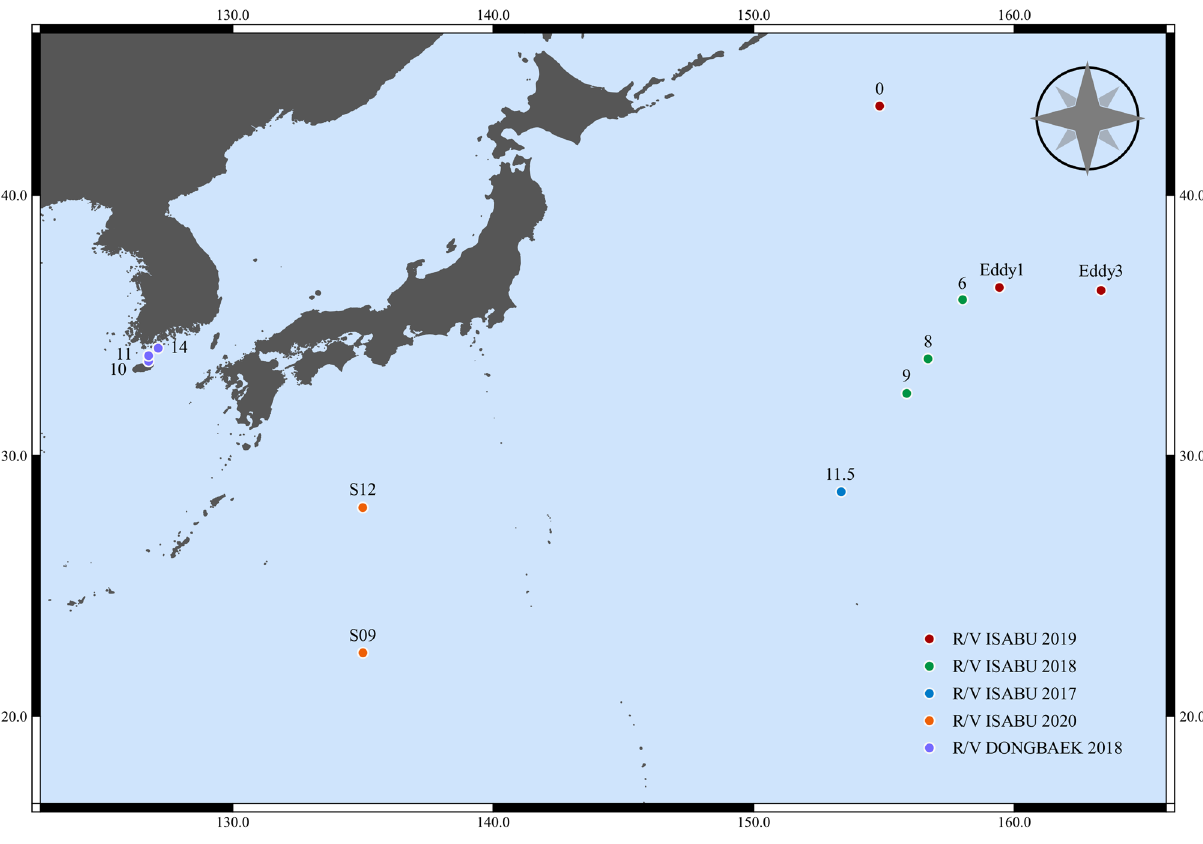
Figure 1. Map of collecting stations marked with the